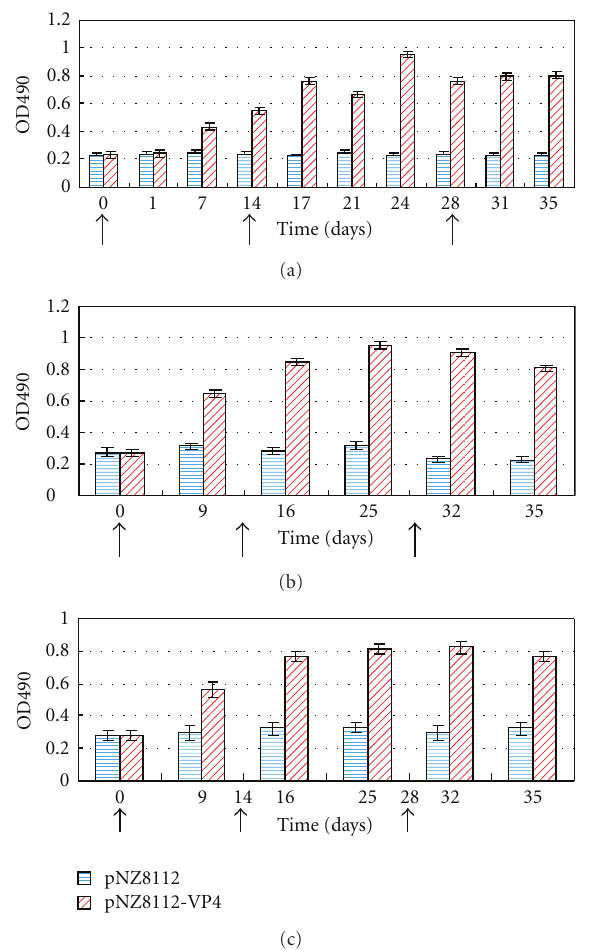
Figure 5: Anti-VP4-specific IgA responses. Specific anti-VP4 IgA was measured in fecal (a), vaginal washes (b), or lacrimal fluids (c). Mice were orally immunized with 10 9 CFU of pNZ8112-VP4/NZ9000 and pNZ8112-VP4/NZ9000, respectively. The immune protocol was administered on three consecutive days: immunization at days 0, 1, and 2; a booster at days 14, 15, and 16; and a second booster at days 28, 29, and 30 (the arrows on the X - axis indicate the times of vaccination and boosters). Samples from fecal extracts, vaginal washes, and lacrimal fluids were analyzed for the presence of specific Anti-VP4 IgA by ELISA. The OD value of each replicate well is the one of the mixture of two samples; the bars represent IgA mean OD values in four wells representative of eight samples, which were detected at di ff erent time points for each group.